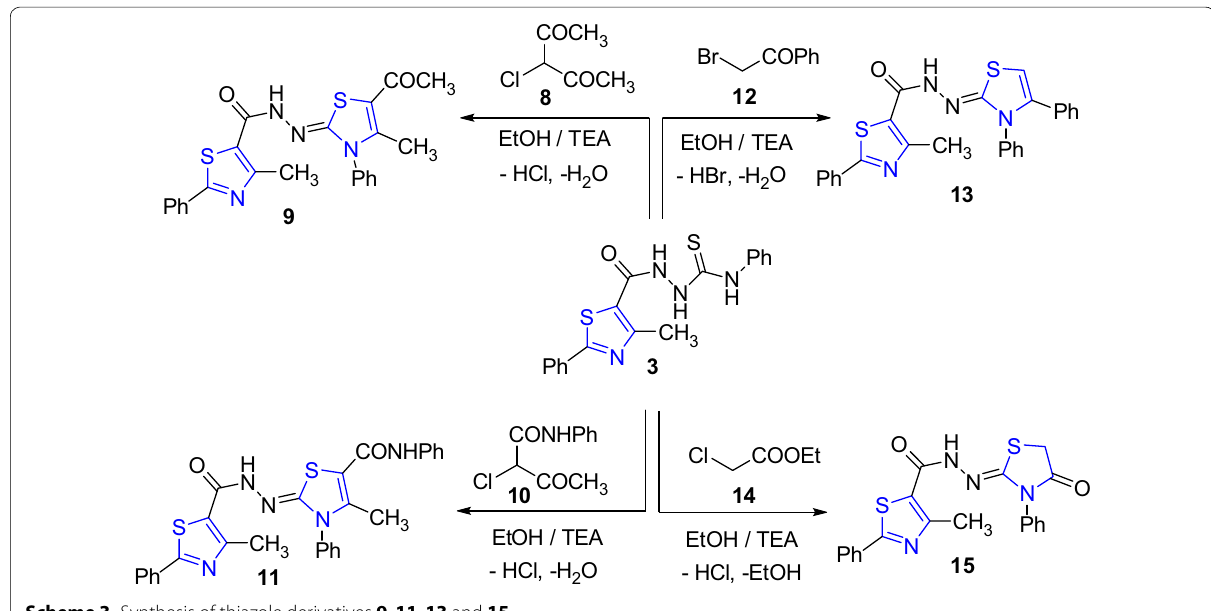
Scheme 3 Synthesis of thiazole derivatives 9 , 11 , 13 and 15